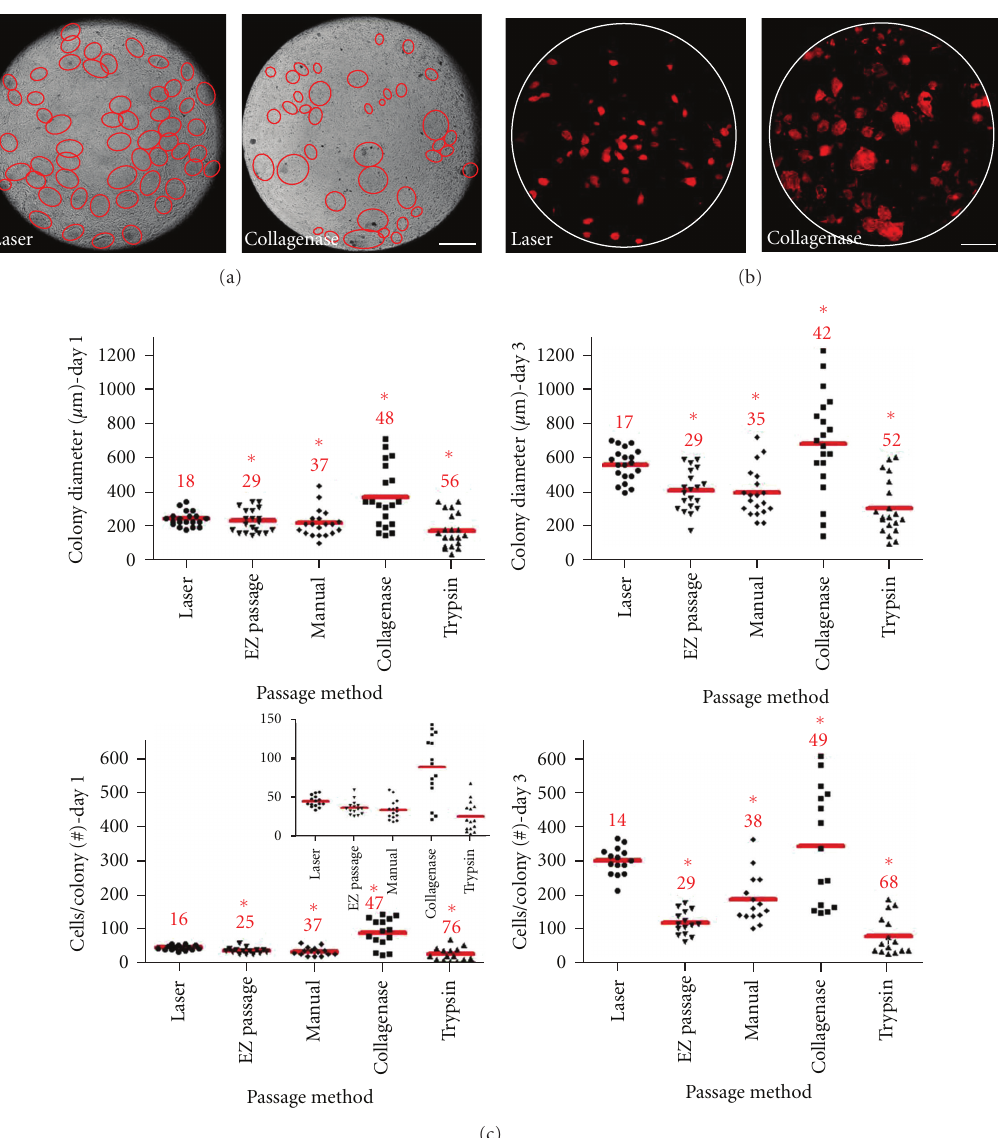
Figure 2: Improved uniformity of stem cell cultures by laser-mediated passage. (a) Brightfield images of iPSC cultures 2 days after laser- mediated passage (200 μ m sections, left) or collagenase passage (right). Colonies are shown by red outline. Scale bar, 1 mm. (b) Alkaline phosphatase (AP) staining of iPSC colonies 1 day after laser-mediated passage (200 μ m sections, left) or collagenase passage (right). Scale bar, 1mm. (c) Colony size of iPSC cultures on days 1 and 3 after laser-mediated passage (200 μ m sections), StemPro EZPassage Disposable Stem Cell Passaging Tool (EZ Passage), manual passage using a pipette tip, collagenase treatment, or trypsin dissociation of cells. Longest diameter of each colony was manually measured using brightfield images (top, n = 20 colonies per data point). Number of cells per colony was manually counted using Hoechst stained cultures (bottom, n = 15 colonies per data point). Data are shown as scatter plot with red line indicating mean. The CV is shown in red text above each sample. Asterisks ( ∗ ) indicate variances that are statistically significant when compared to laser-mediated passage using ANOVA, with a P ≤ 0 . 05 considered